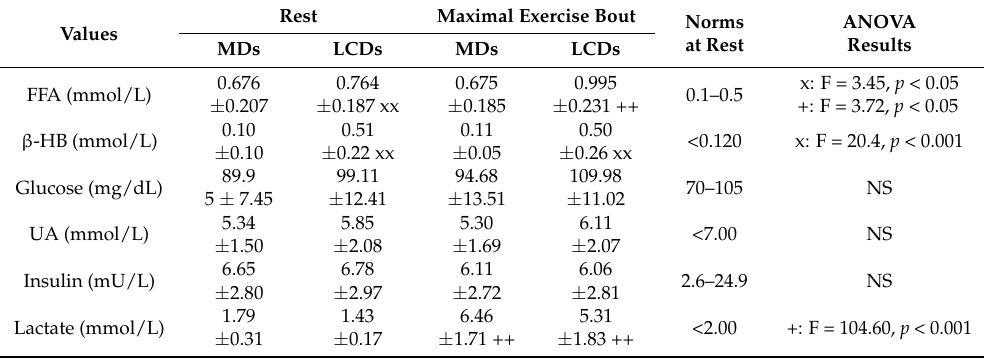
Table 3. Biochemical variables assessed from blood samples of fasting participants in the low carbohydrate diets (LCDs) and mixed diets (MDs) groups. Rest Maximal Exercise Bout Norms Values at Rest